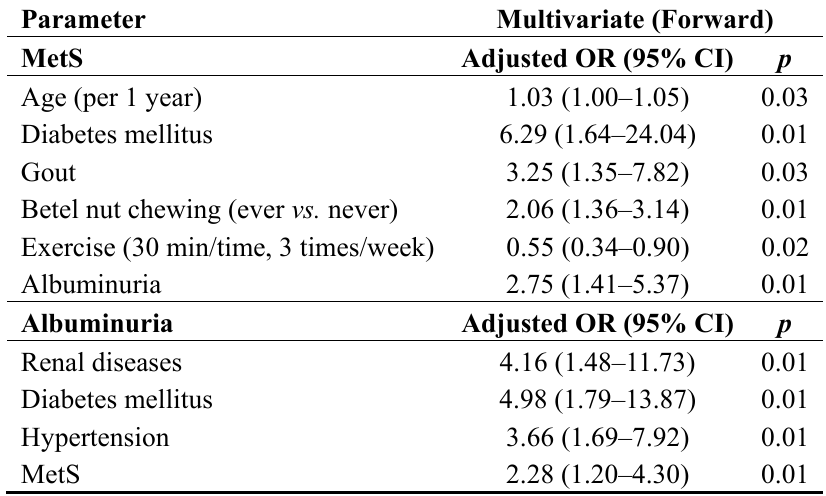
Table 4. Determinants of metabolic syndrome (MetS) and albuminuria in occupational